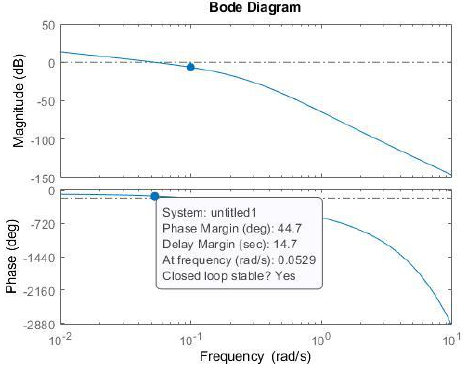
Figure 6. Bode diagram of the open-loop system for the first designed FO-PI controller.